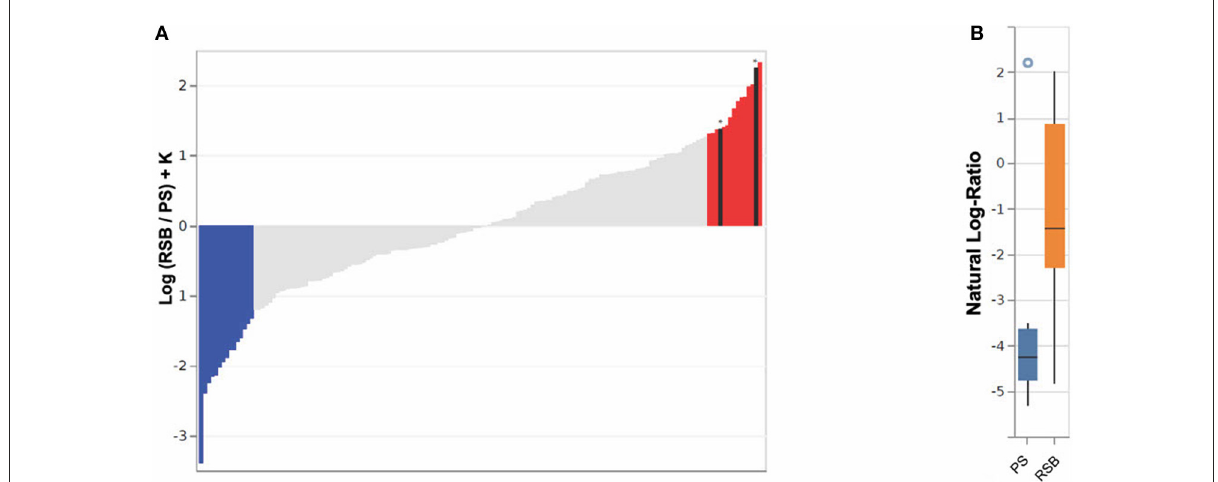
FIGURE3 Bacterial ASVs associated with RSB or PS consumption at time point five, using 16S analysis. (A) A rank plot highlights the differentials for the top 10% of ASVs ( n = 15) associated with RSB (colored in red) and the bottom 10% ( n = 15) associated with PS (colored in blue). ASVs classified as Akkermansia muciniphila (second from right) and Faecalibacterium prausnitzii (twelfth from right), (see Table S4) are shown in black with an asterisk above. The y-axis shows the log-fold change known up to a bias constant K. (B) Boxplot of the log-ratio of the two ASVs assigned as Akkermansia muciniphila and Faecalibacterium prausnitzii over the top 10% ( n = 15) associated with